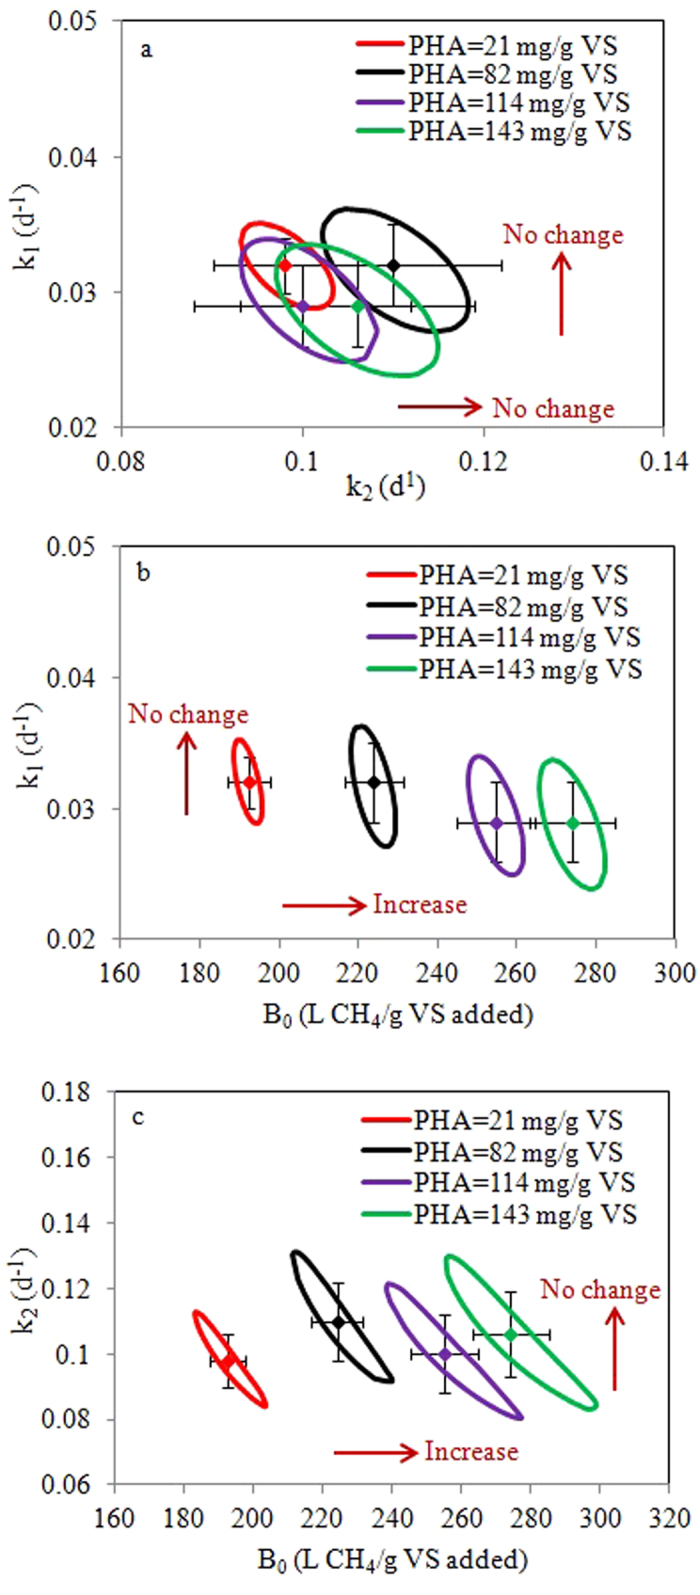
Confidence regions (95%) of the estimated k1 and k2, k1 and B0, and k2 and B0.